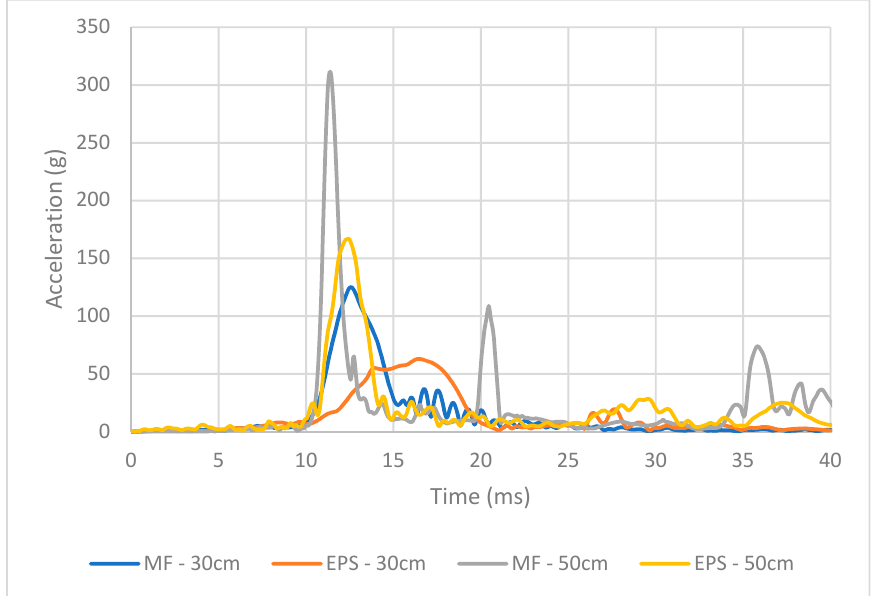
Figure 9. Example of acceleration vs. time curve during impact response from each of the experi- mental treatments.